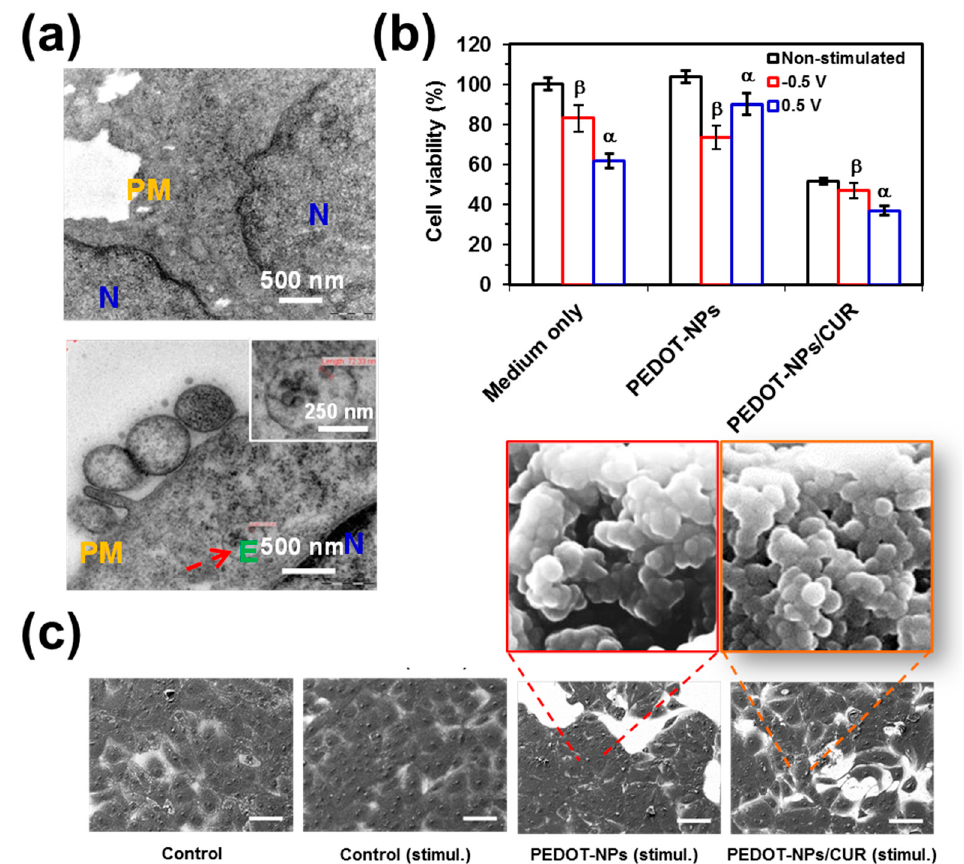
Figure 3. ( a ) TEM images of cells incubated without and with PEDOT-NPs (25 mg / mL) for 24 h (top and bottom, respectively). Read arrows indicate the PEDOT-NPs. N, E and PM refer to nucleus, endosome and plasma membrane. ( b ) Relative cell viability of PC-3 cells cultured on stainless steel pins (control), PEDOT-NPs and PEDOT-NPs / CUR non-stimulated and after one pulse of 30 s of 0.5 V or − 0.5 V. The data points correspond to the average of three samples and the error bars refer to the respective standard deviation. Greek letters in the columns indicate a significant di ff erence ( p < 0.05) when one-way ANOVA and Turkey’s multiple comparison tests have been applied. ( c ) SEM micrographs (scale bar: 100 µ m) of cell growth onto the non-stimulated control and electro-stimulated (one pulse of 30 s of 0.5 V) control, PEDOT-NPs and PEDOT-NPs / CUR. Magnifications (scale bar: 100 nm)